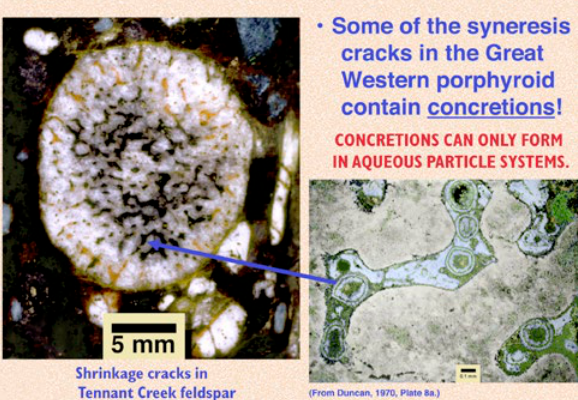
Figure 23. Quartz oolites in siliceous shale from the Explorer 12 prospect at Tennant Creek and haematite oolites in the granite adjacent to the large Olympic Dam orebody in South Australia is further clear evidence that the granite crystallised from diffusive gelatinous